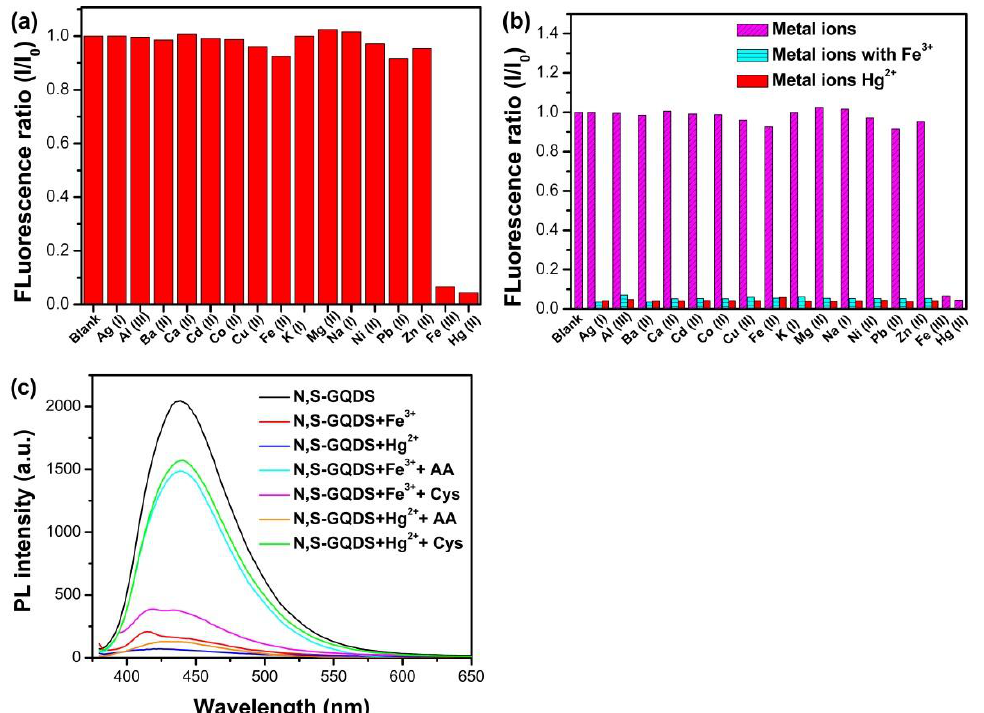
Figure 8. ( a ) The fluorescence quenching ratio of as-synthesized N, S-GQDs toward various cations; ( b ) the interfering test of N, S-GQDs; ( c ) the fluorescence spectra of N, S-GQDs before and after the addition of 50 μM Fe 3+ , 50 μM Hg 2+ , 100 μM AA, and 50 μM Cys, respectively.